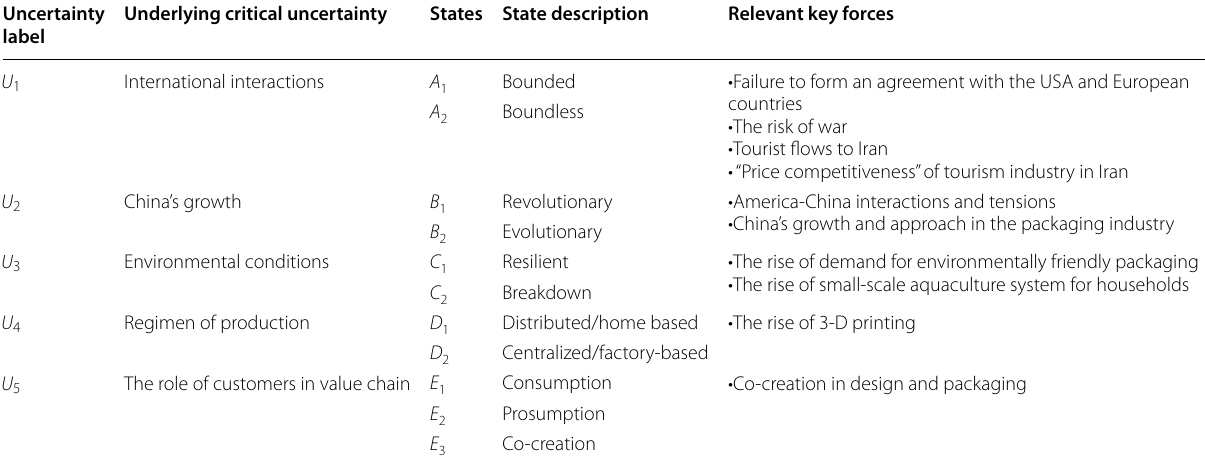
Table 4 Different states of driving forces, their designated name, and labels Uncertainty